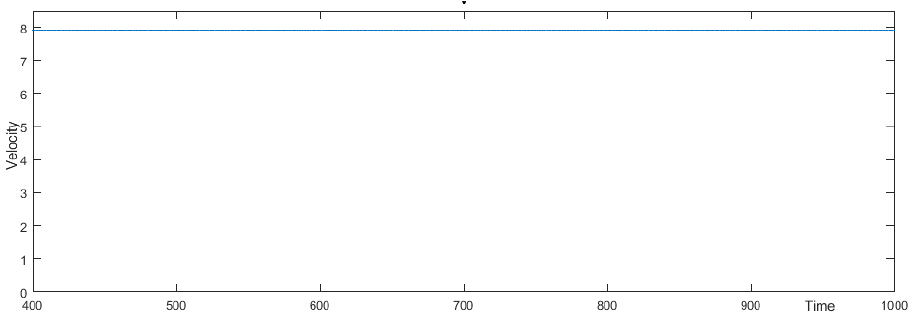
Figure 7. v evolution taking v 0 = 0.01.